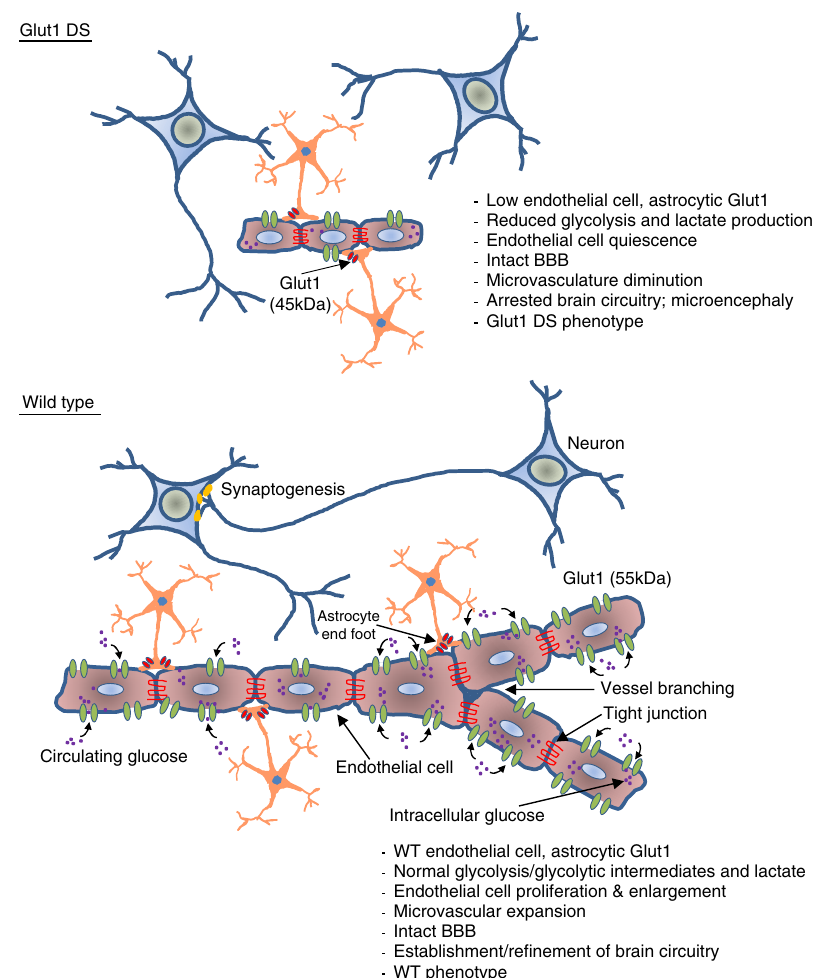
Figure 8 | Relationship between brain microvasculature defects and Glut1 deficiency. A model illustrating the direct as well as indirect effects of reduced Glut1 protein on brain microvascular ECs and the consequences of such a reduction first, on the capillary network and then on brain circuitry. Note that the BBB remains intact in the absence of overt cell loss and that ECs express 20–30 times more Glut1 than do